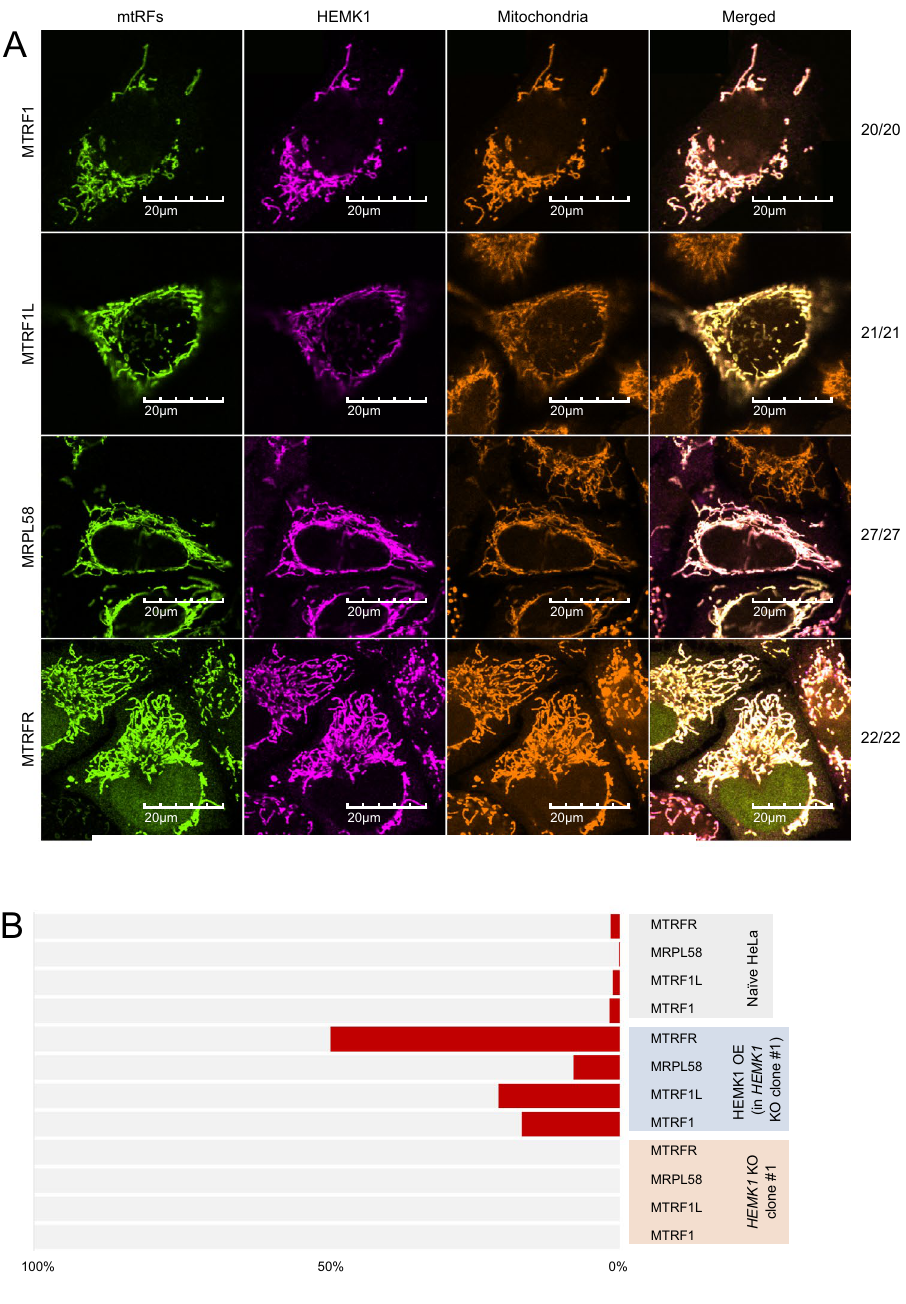
Figure 2. Glutamine methylation in the “GGQ” motif of four mtRFs mediated by HEMK1. ( A ) Subcellular localization of transiently expressed exogenous HEMK1 and mtRFs in HeLa cells. Representative images of the cell expressing both HEMK1-cFLAG and individual mtRF-cHA were shown. The number of cells showing the colocalization of mtRF, HEMK1, and MitoTracker per the number of analyzed cells are shown in the right side of the panels. Cells with both HEMK1-cFLAG and individual mtRF-cHA co-expressed were analyzed. Note that, although some cells showed mtRFs-cHA and/or HEMK1-cFLAG in the nucleus possibly because of too-much expression of transgene(s), we excluded these cells for quantification to avoid collecting abnormal phenotypes. HEMK1-cFLAG, magenta; mtRFs-cHA, green; MitoTracker Red, orange. Scale 20 μm in total length. ( B ) Approximate methylation efficiency. Stably expressed exogenous mtRFs-cHA in naïve HeLa, HEMK1 KO clone #1, and HEMK1 KO clone #1 complemented with stably expressed HEMK1-cFlag. For fragment counts and methylation ratio of each methylated peptide, see Figure S5A. ( C ) MS1 spectra of mtRFs. Theoretical mass corresponds to specific methylated mtRFs peptides. See Table S2 for detailed MS2 spectra and chromatograms of methylation of each